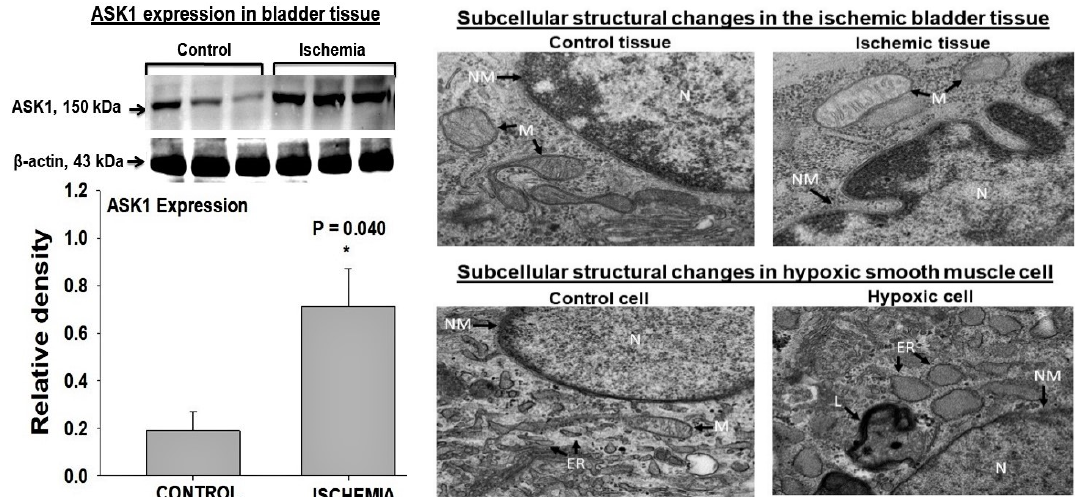
Figure 5. Western blotting ( left panel ) shows significant upregulation of ASK1 in ischemic rat bladder tissues [42]. Transmission electron microscopy ( right panel ) suggests widespread apoptotic activities in both ischemic bladder tissues and hypoxic smooth muscle cells involving the nucleus (N), nuclear membrane (NM), mitochondria (M), and endoplasmic reticulum (ER) and increased levels of lysosomes (L). The bladder tissue figures are reduced from 18,500×. The smooth muscle cell figures are reduced from 13,000×. This figure is taken from our previous publication [42].